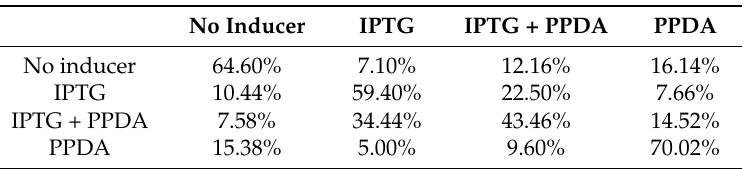
Table 4. PLS predictions of the riboswitch set. Confusion matrix of inducer condition prediction using binary coding